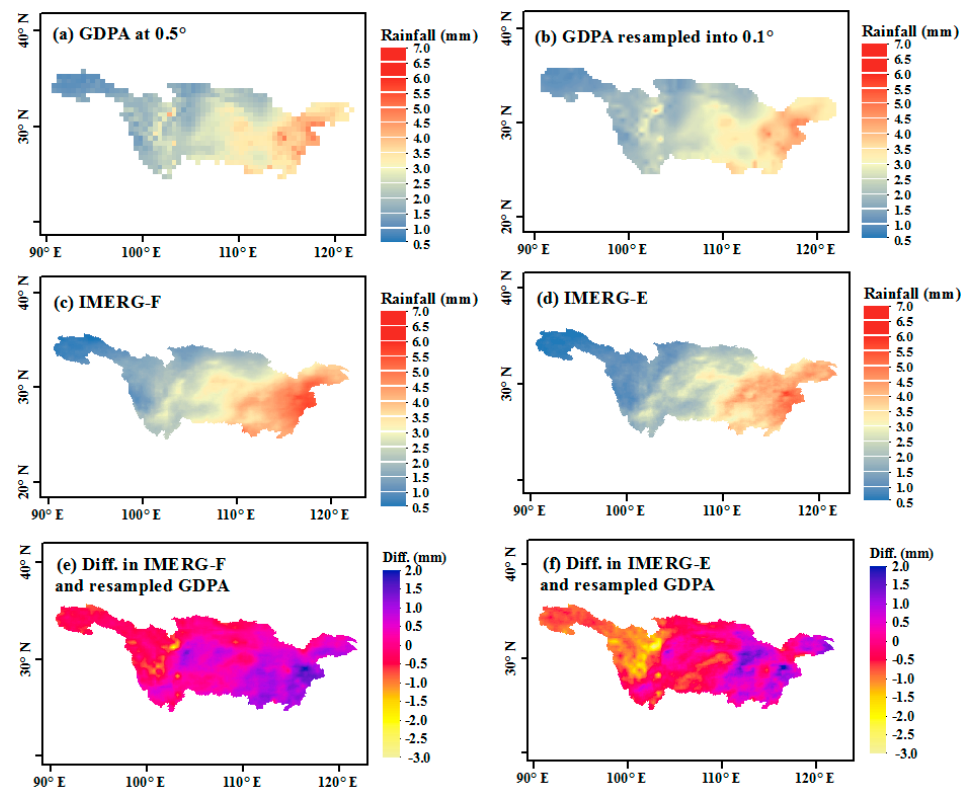
Figure 5. Spatial distribution of average daily (a) ground gridded reference precipitation, GDPA at raw 0.5° spatial resolution, (b) GDPA resampled at 0.1° spatial resolution, (c) “Final” post-real-time satellite precipitation estimates, IMERG-F, (d) raw “Early” near-real-time satellite precipitation estimates, IMERG-E selected to bias correct in this study, (e) difference (Diff.) between IMERG-F and resampled GDPA, and (f) Diff. between IMERG-E and resampled GDPA.